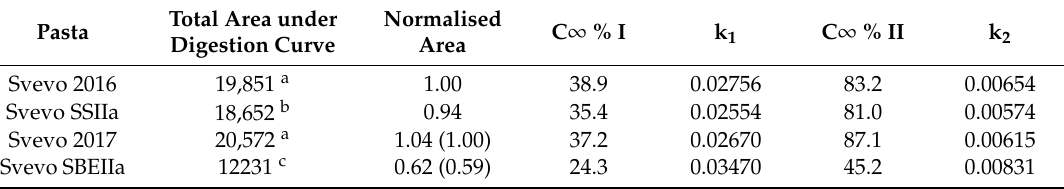
Table 5. Kinetic parameters of digestibility of di ff erent pasta